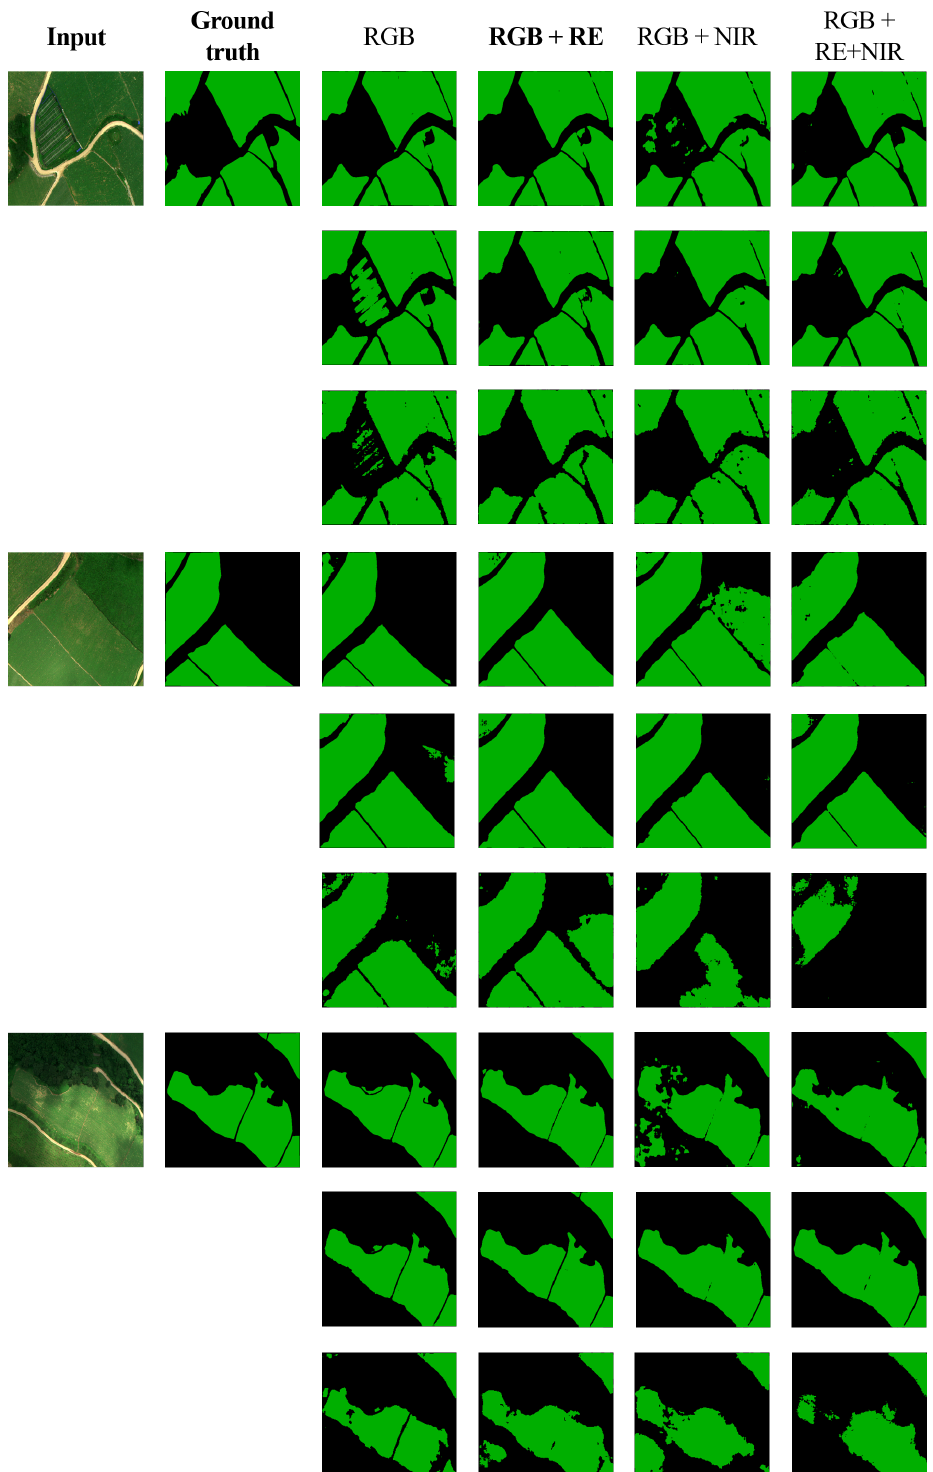
Figure 8. Visualization of model predictions for three representative examples from the GNM dataset. There were input images and ground truth in the first and second columns. Prediction results are represented from the third column to the sixth column. Results of DeepLab V3+, U-Net, and SegNet are repeatably visualized from the first row to the final row. The area occupied by each input in Gwinemi is about 1.77 ha. Each input image width and height of DeepLab V3+, U-Net, and SegNet is 513, 572, and 224,